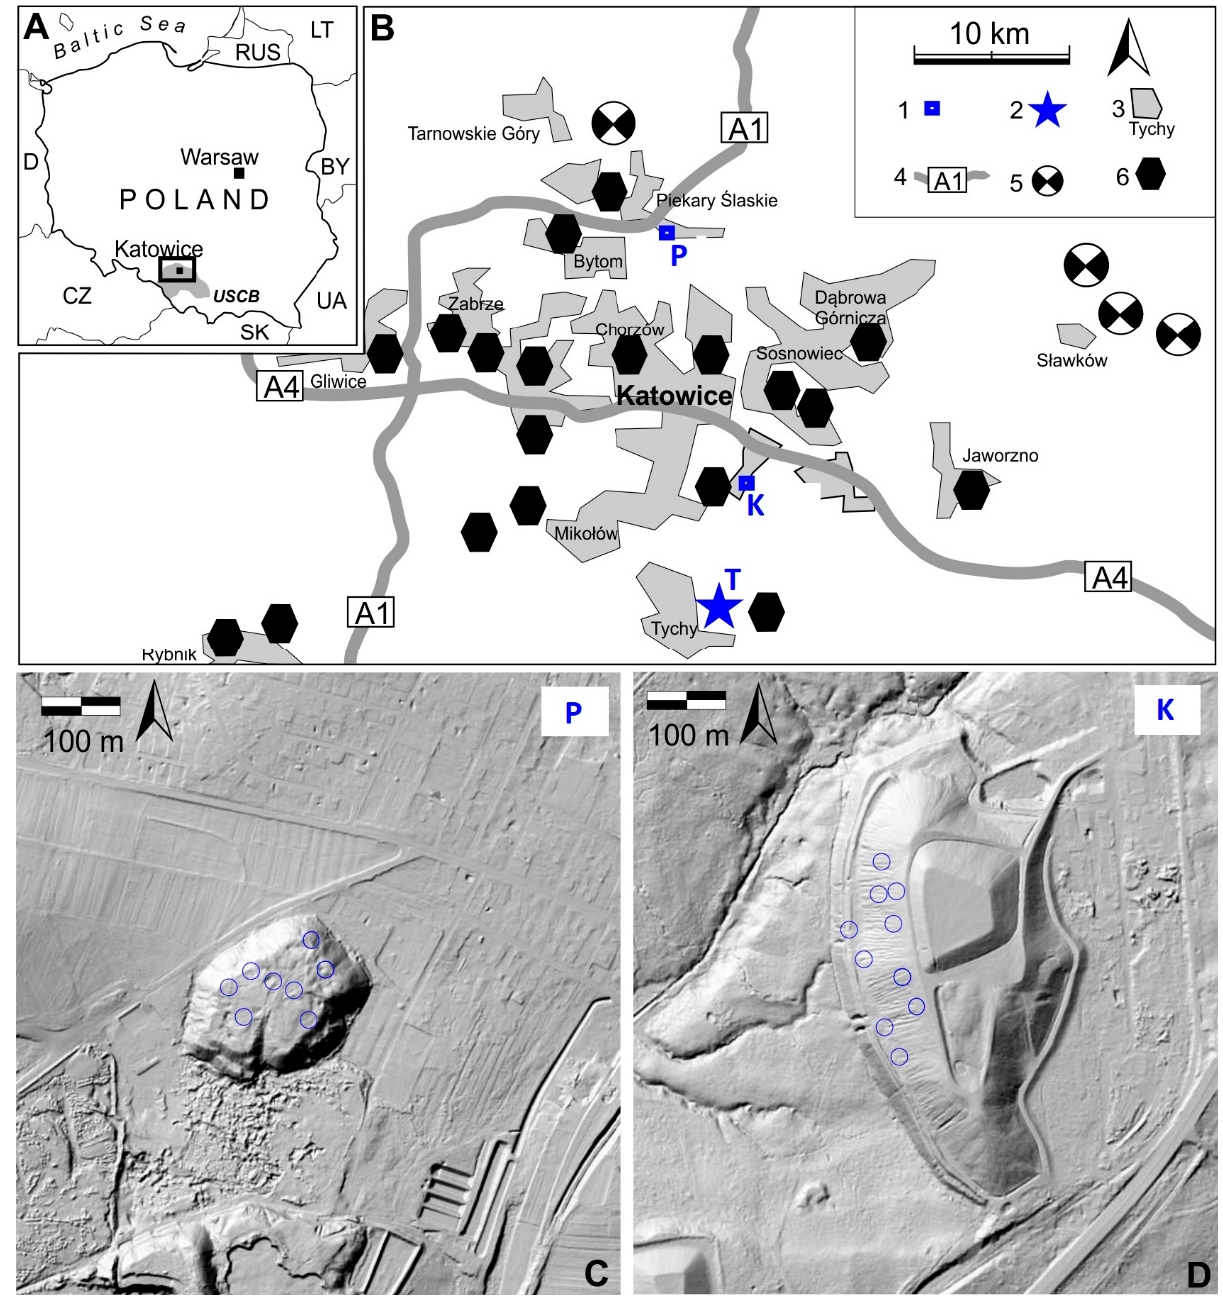
Figure 1. Location of the study area in the southern part of Poland ( A ), a schematic map of the Upper Silesia Industrial Region ( B ): 1—location of research sites (K—Katowice Murcki; P—Piekary ´Sl ˛askie); 2—location of reference site; 3—urbanised area; 4—main highways; 5—location of old zinc and lead mines; 6—location of main coal mines, both old and in operation. Morphology of lead–zinc ore spoil heap in Piekary ´Sl ˛askie ( C ), and post-coal mine spoil heap in Katowice ( D ) with location of sampling sites (blue circles). Abbreviations: T—reference population from Tychy; K—birch population from post-coal mine spoil heap; P—birch population from post-smelter spoil